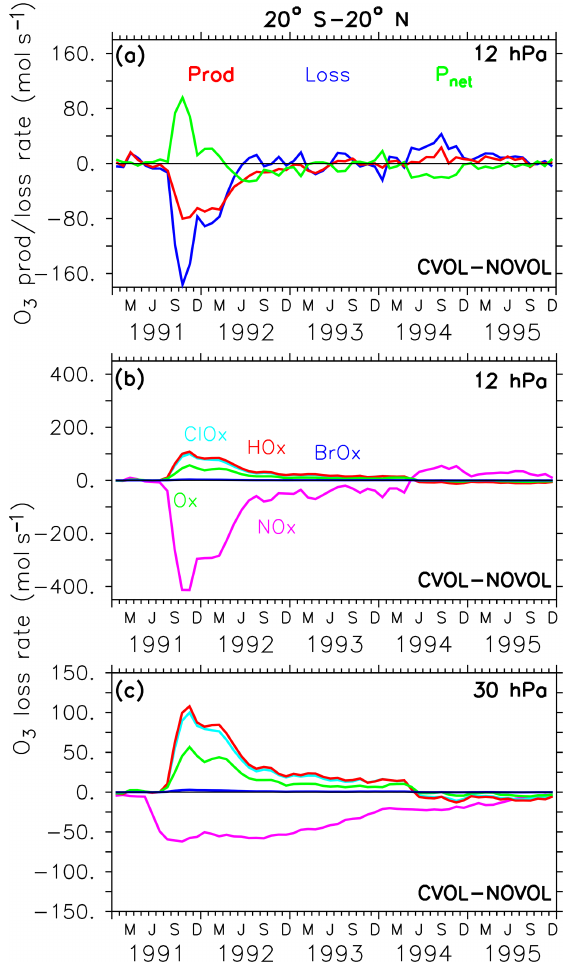
Figure 10. Differences (CVOL − NOVOL), i.e. chemical effect of ozone production (Prod) and loss (Loss) rates and corresponding net ozone production ( P net = Prod − Loss) (a) at 12hPa. Differ- ences (CVOL − NOVOL) in the ozone loss rates (moleculess − 1 ) for each catalytic ozone loss cycle of CVOL − NOVOL at 12hPa (b) and 30hPa (c) . The level shown (12hPa) is located at the maximum of the volcanic ozone perturbation. Shown are zonally averaged and latitudinally (20 ◦ S and 20 ◦ N) summed rates in molecules per sec-